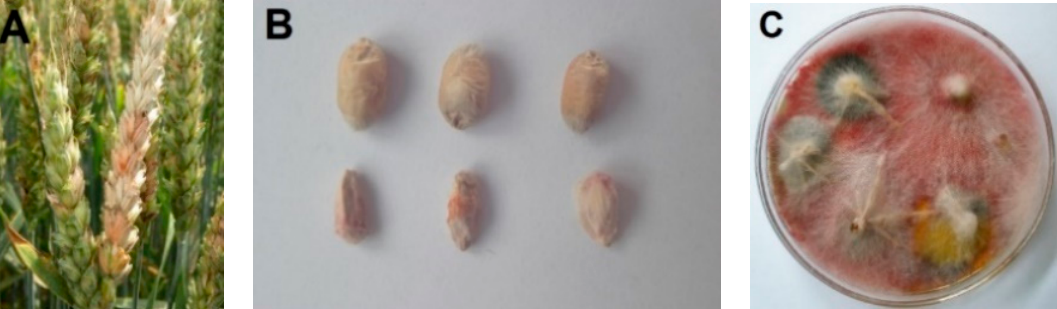
Figure 1. ( A ) Fusarium head blight; ( B ) Fusarium disease on grains; ( C ) infestation of grains by Fusarium